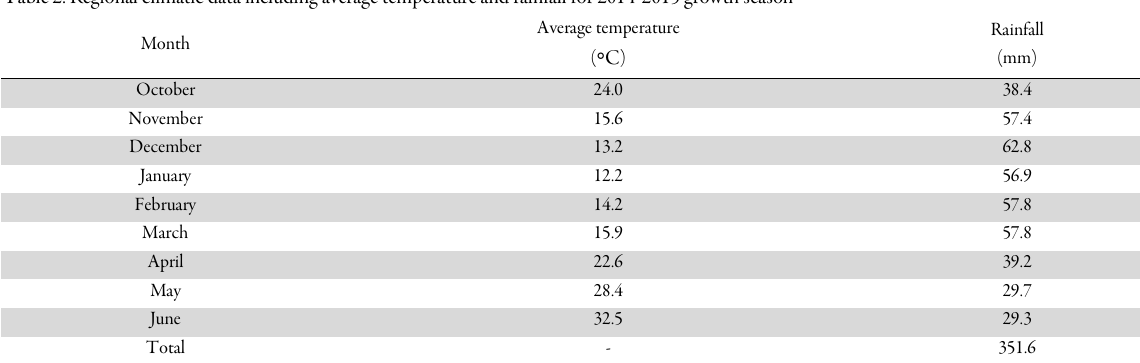
Table 2. Regional climatic data including average temperature and rainfall for 2014-2015 growth